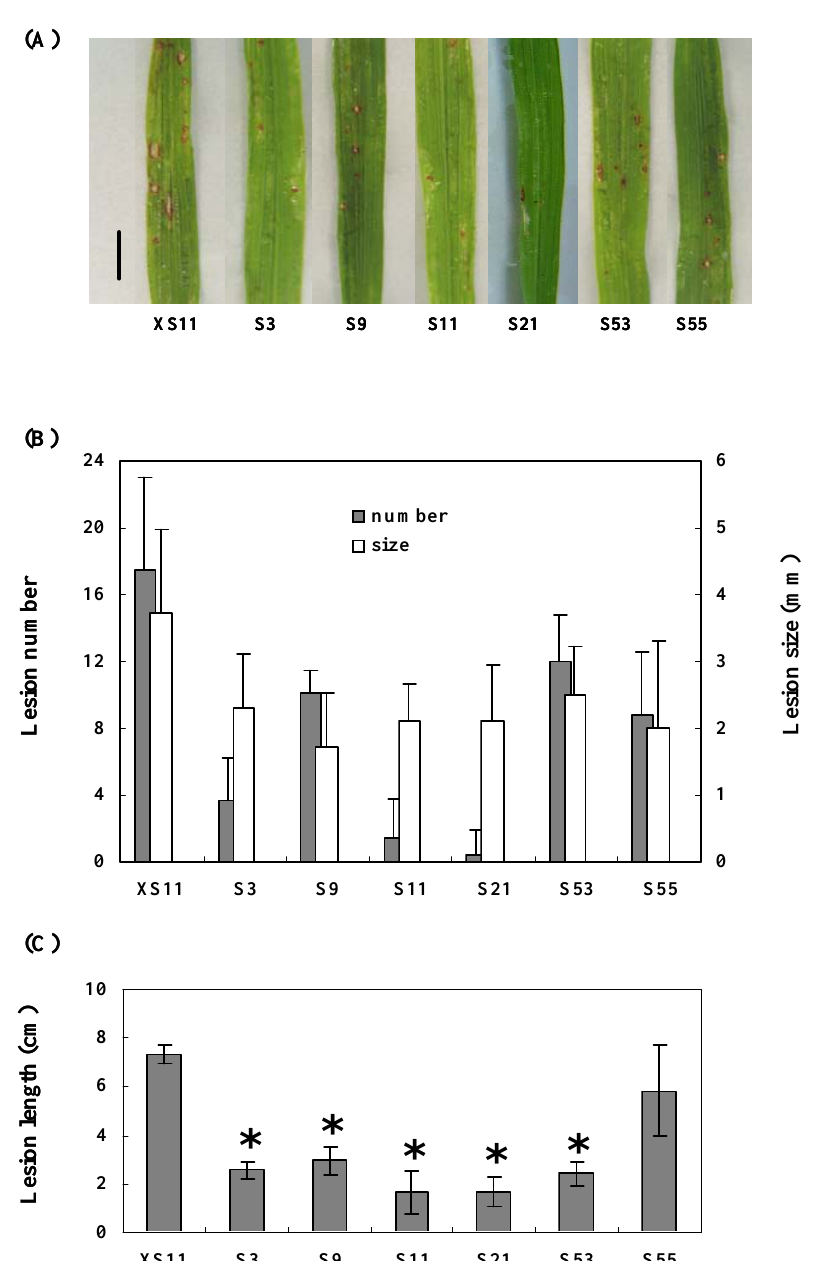
Figure 6. The resistance to Magnaporthe oryzae and Rhizoctonia solani of overexpression rice